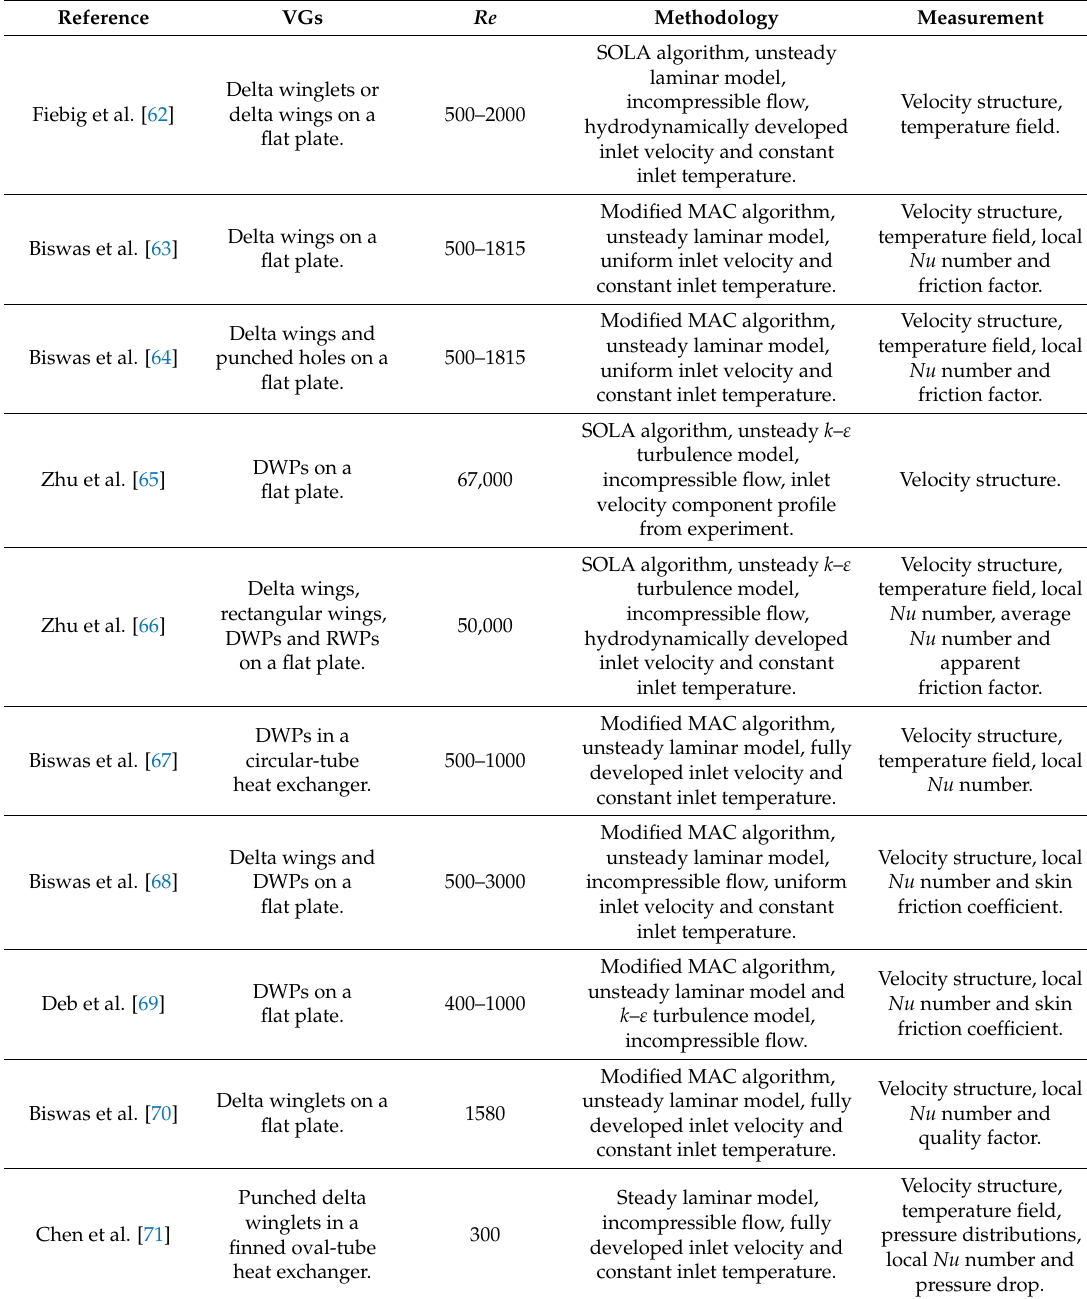
Table 2. Representative numerical studies of airside thermohydraulic performance with vortex generators on heat transfer